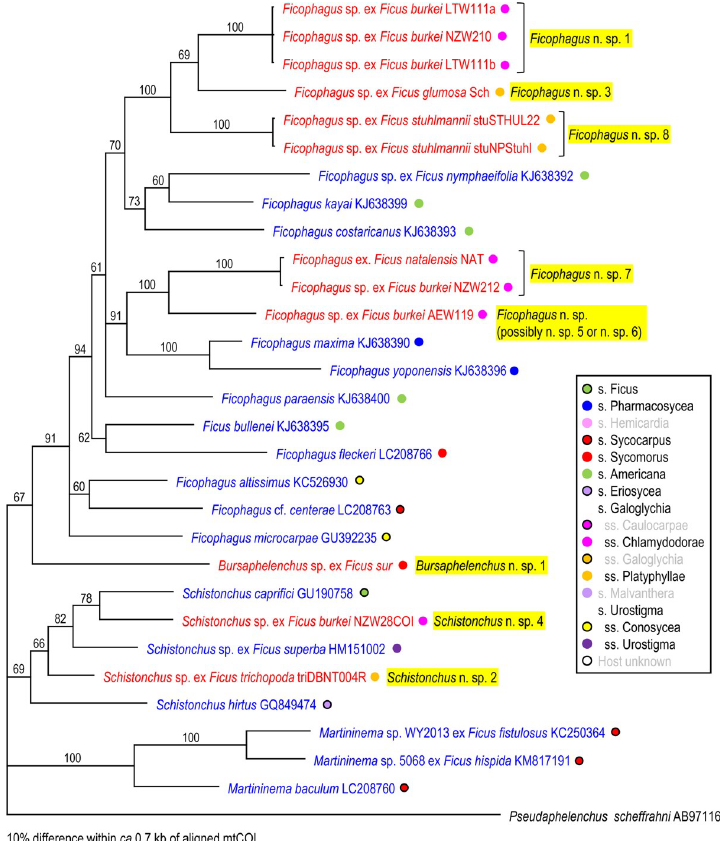
Fig 4. Phylogenetic relationship of fig-associated Aphelenchoididae species inferred from mtCOI under GTR+G +I model. The parameters are: AIC = 13195.267, lnL = -6530.39, freqA = 0.22, freqC = 0.12, freqG = 0.20, freqT = 0.46, R(a) = 0.07, R(b) = 2.45, R(c) = 1.17, R(d) = 0.49, R(e) = 2.12, R(f) = 1.00, Pinva = 0.44, Shape = 1.04. Posterior probability values exceeding 50% are given on appropriate clades. Fig-associated nematode species obtained in the present study and previous studies are written in red and blue, respectively. Section or subsection of host fig species are coded with color dots.